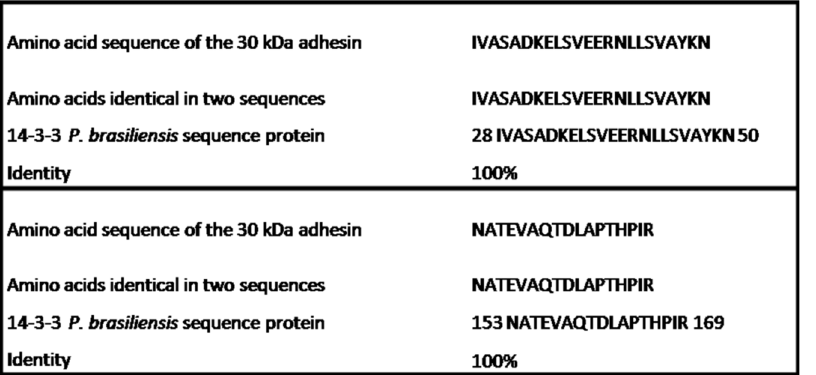
Figure 1. Comparison of the 30 kDa adhesin with the 14-3-3 protein of P.brasiliensis by BLASTp and FASTA 3.